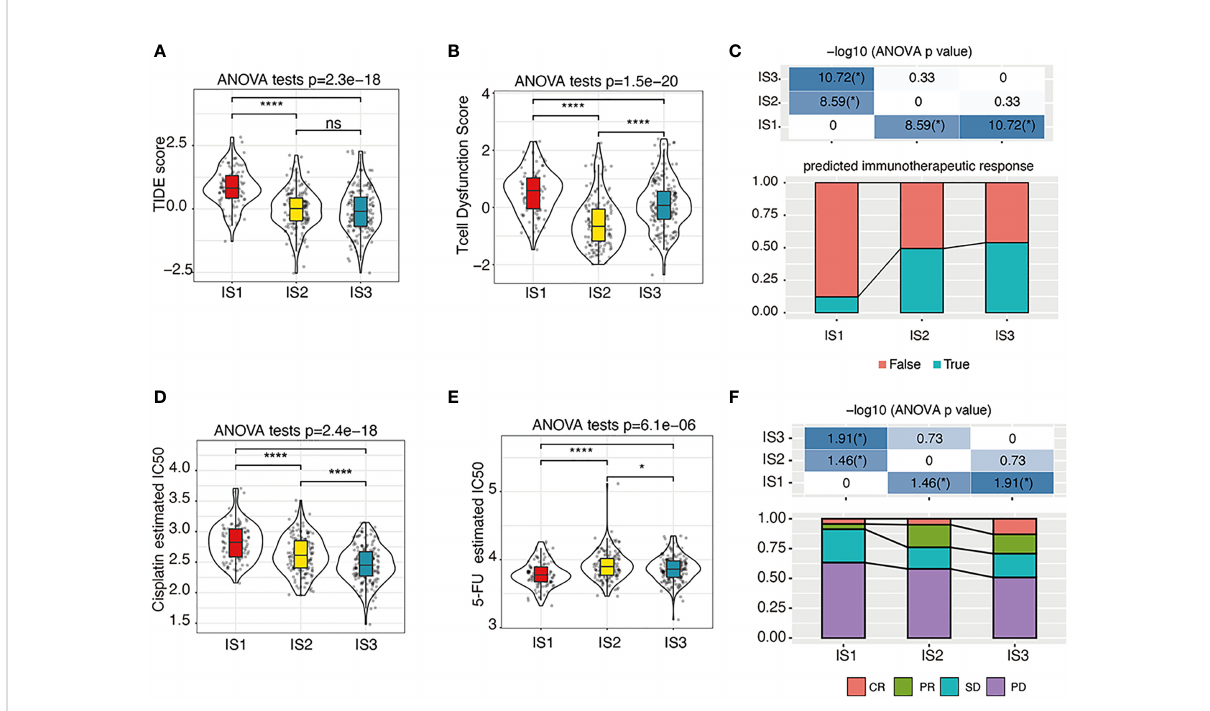
FIGURE 6 The immunotherapy/chemotherapy response of each IS. (A – C) . The estimated TIDE score (A) , T-cell dysfunction scores (B) , and predicted immunotherapeutic response statues (C) among immune subtypes. We used the Kruskal – Wallis test and Wilcoxon test to compare the signi fi cance among the three groups and pairwise comparison between groups, respectively. The solid black line in the box is the median, and the inner black box in the violin plot represents the quartile range. The black vertical line running through the violin chart represents the interval from the minimum value to the maximum value, respectively. n.s, not signi fi cant, * P < 0.01 and **** P < 0.00001. (D, E) . The predicted cisplatin (D) and 5-FU (E) chemotherapeutic response statues among immune subtypes. We used the Kruskal – Wallis test and Wilcoxon test to compare the signi fi cance among the three groups and pairwise comparison between groups, respectively. The solid black line in the box is the median, and the inner black box in the violin plot represents the quartile range. The black vertical line running through the violin chart represents the interval from the minimum value to the maximum value, respectively. n.s, not signi fi cant, * P < 0.01 and **** P < 0.00001. (F) . The response statues among immune subtypes in the GSE72970 cohort. PR, partial response; CR, complete response; SD, stable disease; PD, progressive disease. * P <